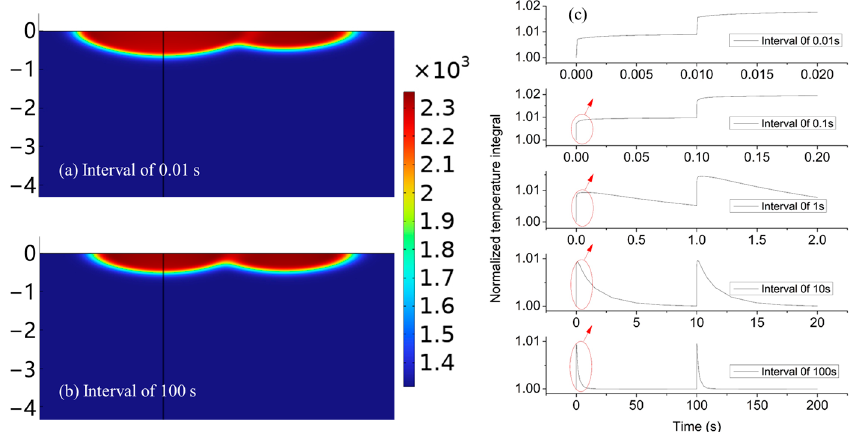
Figure 7. Fictive temperature distribution after two laser irradiations with time intervals of ( a ) 0.001 s and ( b ) 1 s at a spatial overlap of 30%. ( c ) Normalized temperature integral over the modeling domain for different time intervals, in which the duration of the above curve is the same as the duration marked with a red circle on below curve.